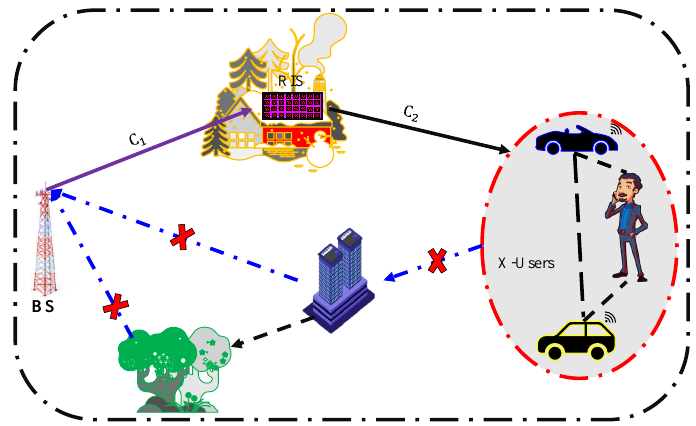
Figure 4. RIS-aided network